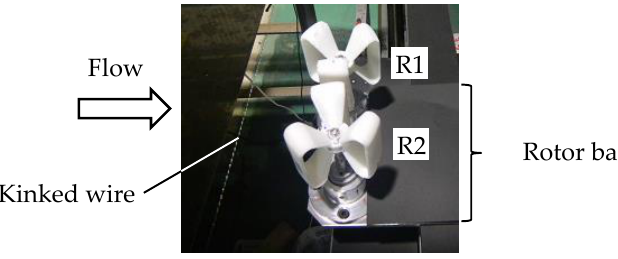
Figure 7. Experimental setup of smoke-wire method (see Figure 11).